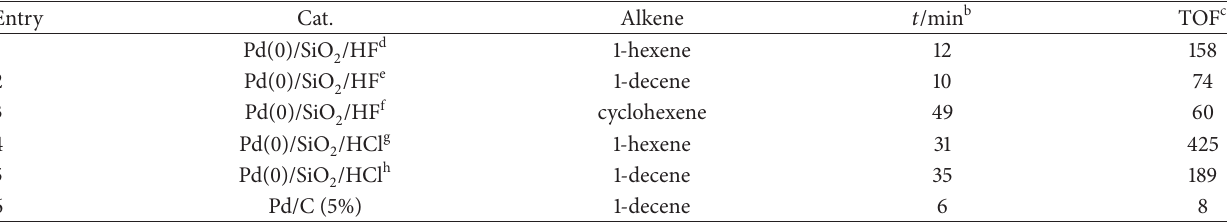
Table 2: Hydrogenation of alkenes at 4atm of H 2 a .